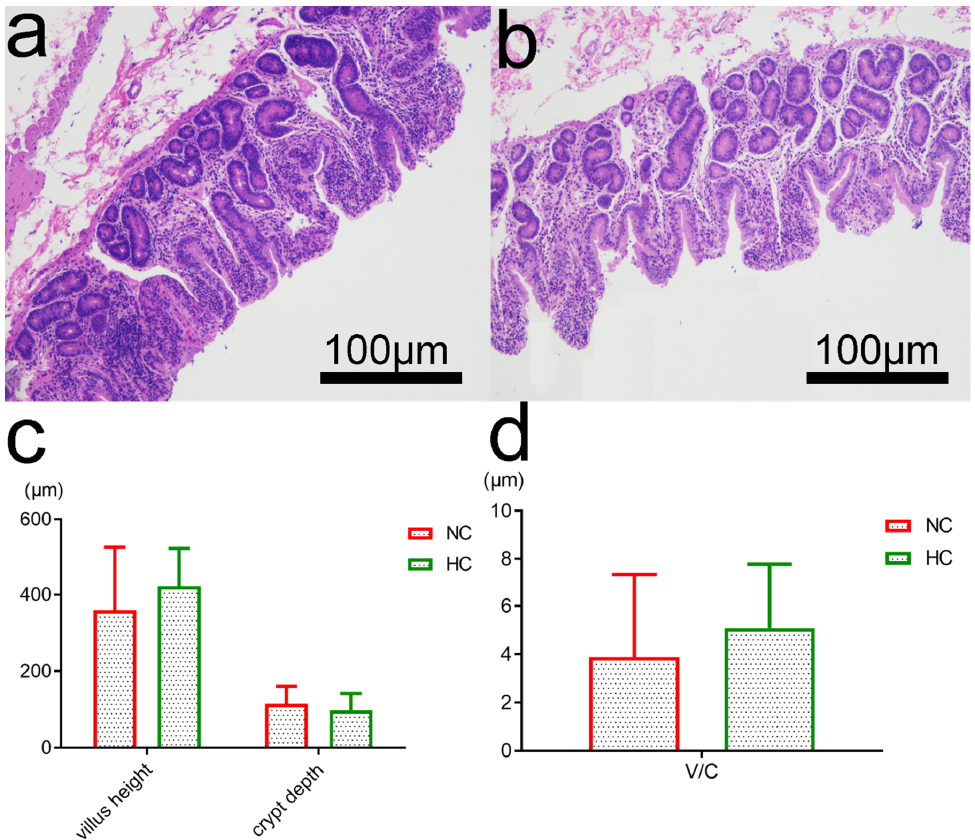
Figure 5. Intestinal morphology of the goats fed normal-concentrate (NC) and high-concentrate (HC) diets. Light microscopy cross-section of ileal tissues from a representative NC-fed goat ( a ) and HC-fed goat ( b ) and the scale bar = 100 µm. Statistical analyses of villlus height and crypt depth ( c ), ( p > 0.1) and the ratio of villus height to crypt depth of ileal morphology in goats ( d ), ( p = 0.530).